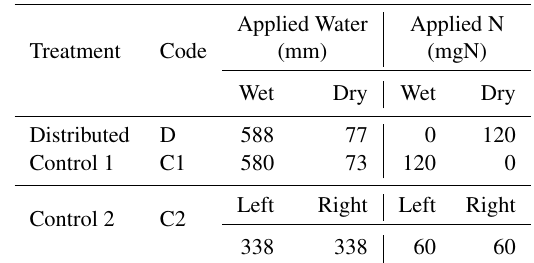
Table 1. Total quantity of water and N applied to each compart- ment of the three treatments. Note that the nutrient solution applied includes other macro- and micronutrients. The composition of the nutrient solution is provided in Table